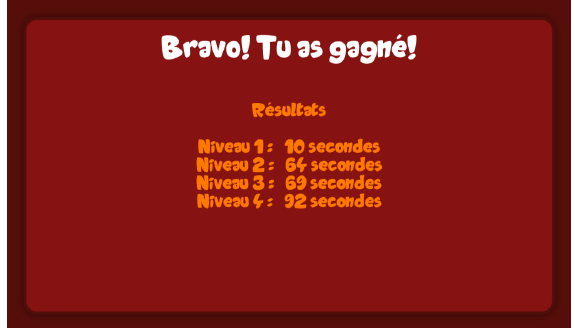
Figure 9. Ludic game: end of the game with results.